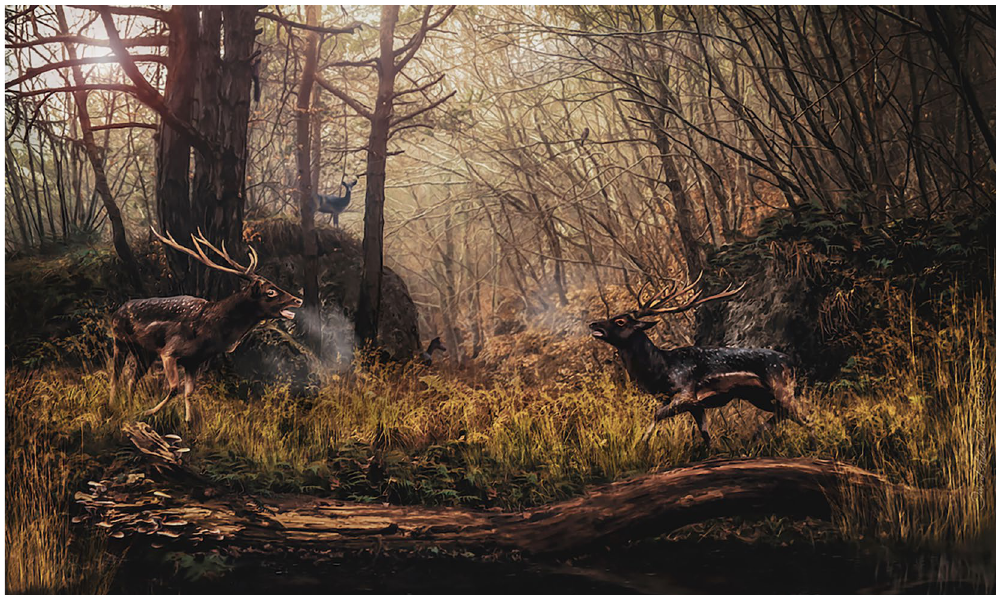
Figure 5. Life appearance of ‘Pseudodama’ nestii represented during the rutting season. The reconstruction is based on the cranial and postcranial material from the Early Pleistocene of Pantalla (Italy) and on literature data. Artwork by D.A.